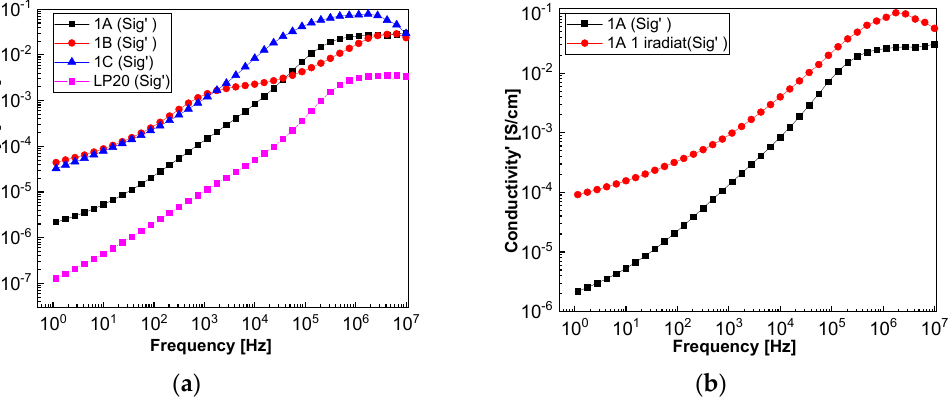
Figure 14. The dependence of real part of conductivity with frequency, in the range of low frequencies, in the case of the 1A, 1B and 1C samples as well as LP ( 1 ) before to exposure to UV light ( a ). ( b ) shows the dependence of the real part of conductivity with frequency in the case of the 1A sample before and after exposure to UV light, labelled as 1A1.